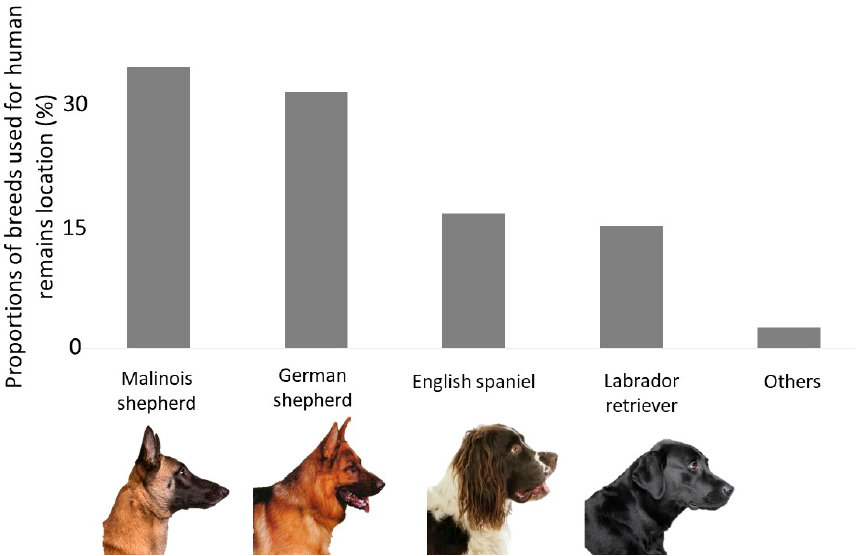
Figure 1. Breeds currently used as human remains detection dogs based on a survey completed by ten brigades from Europe and Canada.